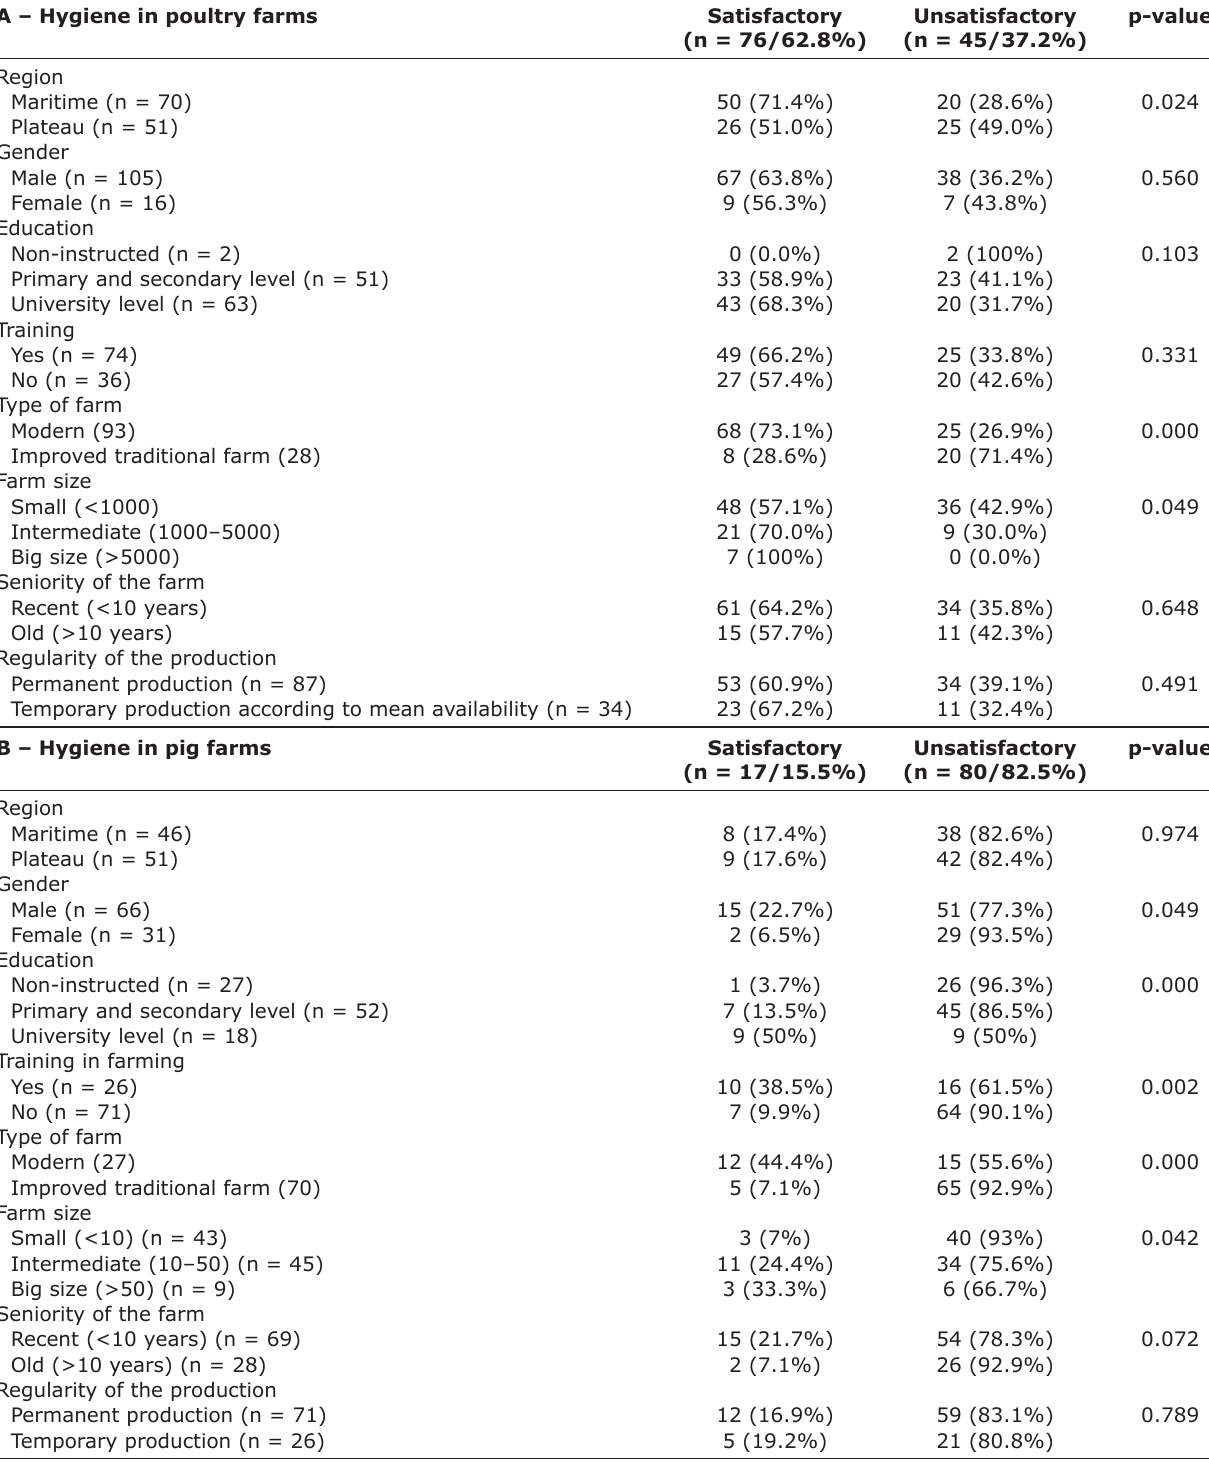
Table-2: Characteristics of poultry and pig farms and hygiene practices of